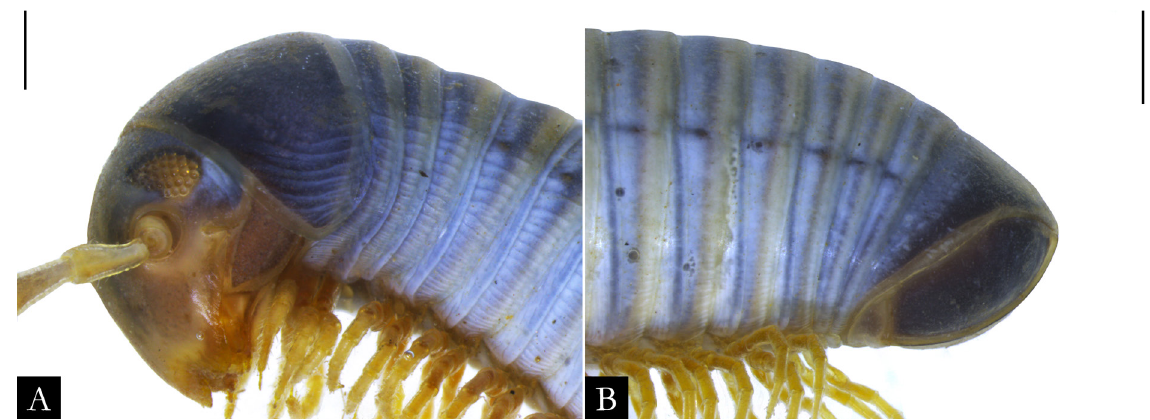
Fig. 95. Pseudonannolene microzoporus Mauriès, 1987, ♀ (IBSP 1368), in lateral view. A . Anterior region. B . Posterior region. Scale bars = 1